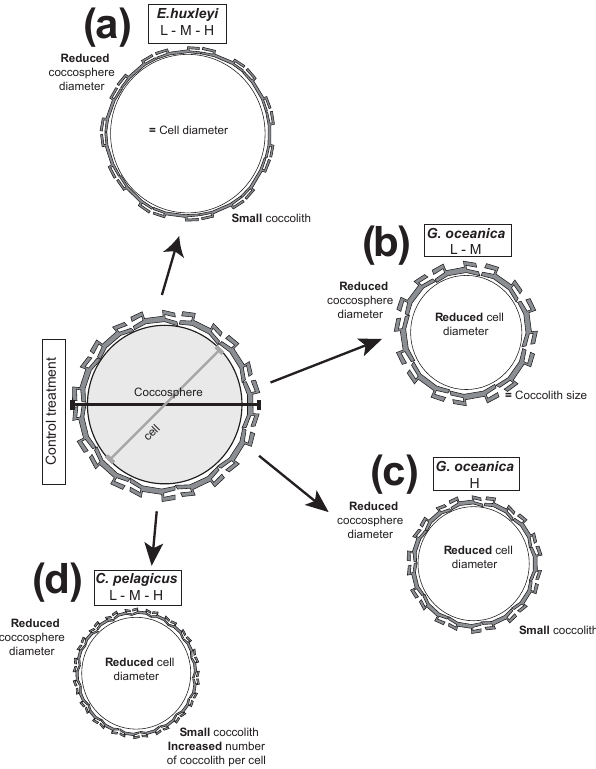
Figure 7. Species-specific responses to trace metal